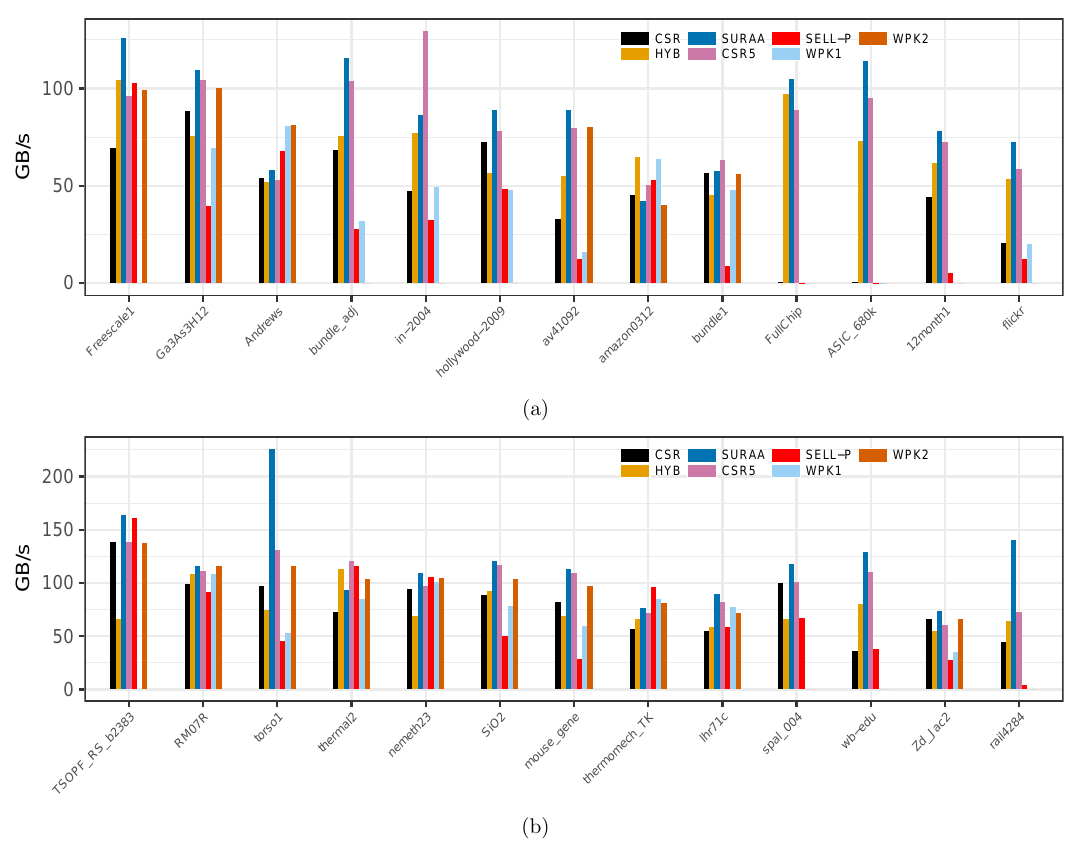
Figure 9. SURAA: Effective bandwidth comparison with the state of the art commercial (cuSPARSE) and open source (CUSP, MAGMA) tools: CSR, HYB, CSR-5, SELL-P, WPK1, and WPK2 for ( a ) the 13 matrices from the benchmark set that provided lowest bandwidths and ( b ) the 13 matrices that provided the highest bandwidth for